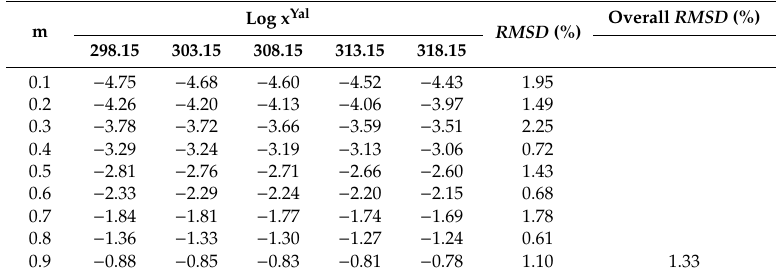
Table 6. Log x Yal values of PPD calculated by Yalkowsky model in binary DMSO + water mixtures at T = 298.2 K to 318.2 K.